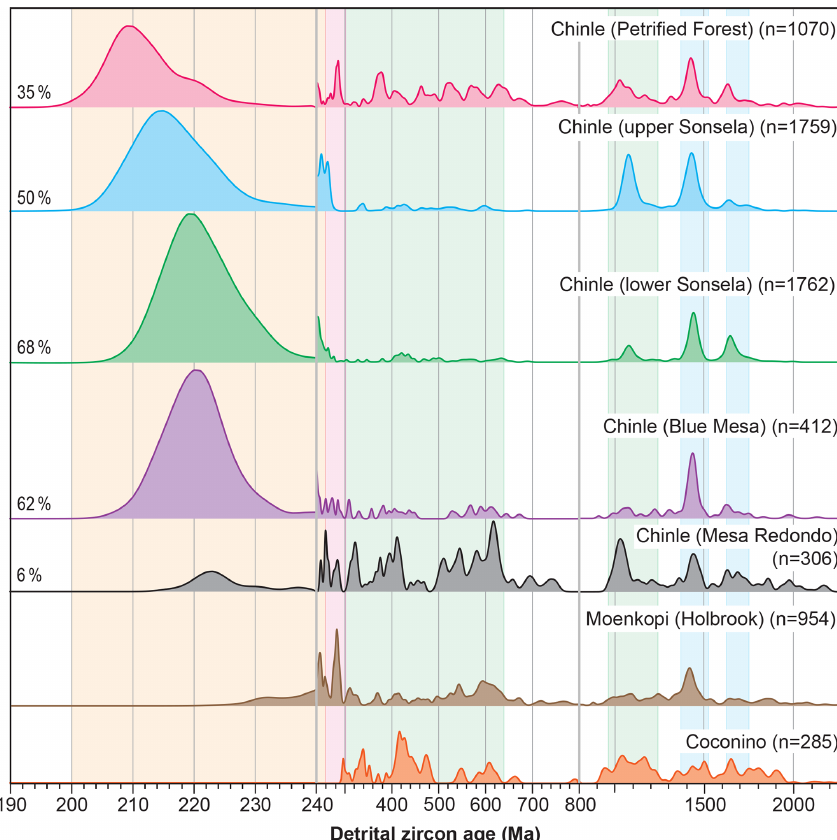
Figure 8. Normalized probability density plots of detrital zircon ages from each set of samples analyzed in this study. Numbers of constituent analyses are shown for each sample. Age distributions older than 240Ma for Chinle strata are exaggerated by a factor of 10 relative to < 240Ma ages. Age distributions for Moenkopi and Coconino sandstones are exaggerated by a factor of 5 relative to Chinle ages. Source regions are interpreted to include local basement rocks (blue bands), the Ouachita orogen (green bands), the East Mexico arc (red band), and the Late Permian–Triassic arc built along the Cordilleran margin (orange band). Results from sample 383-2 are not included in this plot because of its uncertain stratigraphic position. Data from sample 131-2 are omitted because they differ from ages present in other samples from the Petrified Forest Member. The percent of all grains that are < 240Ma in age is shown for each sample on the